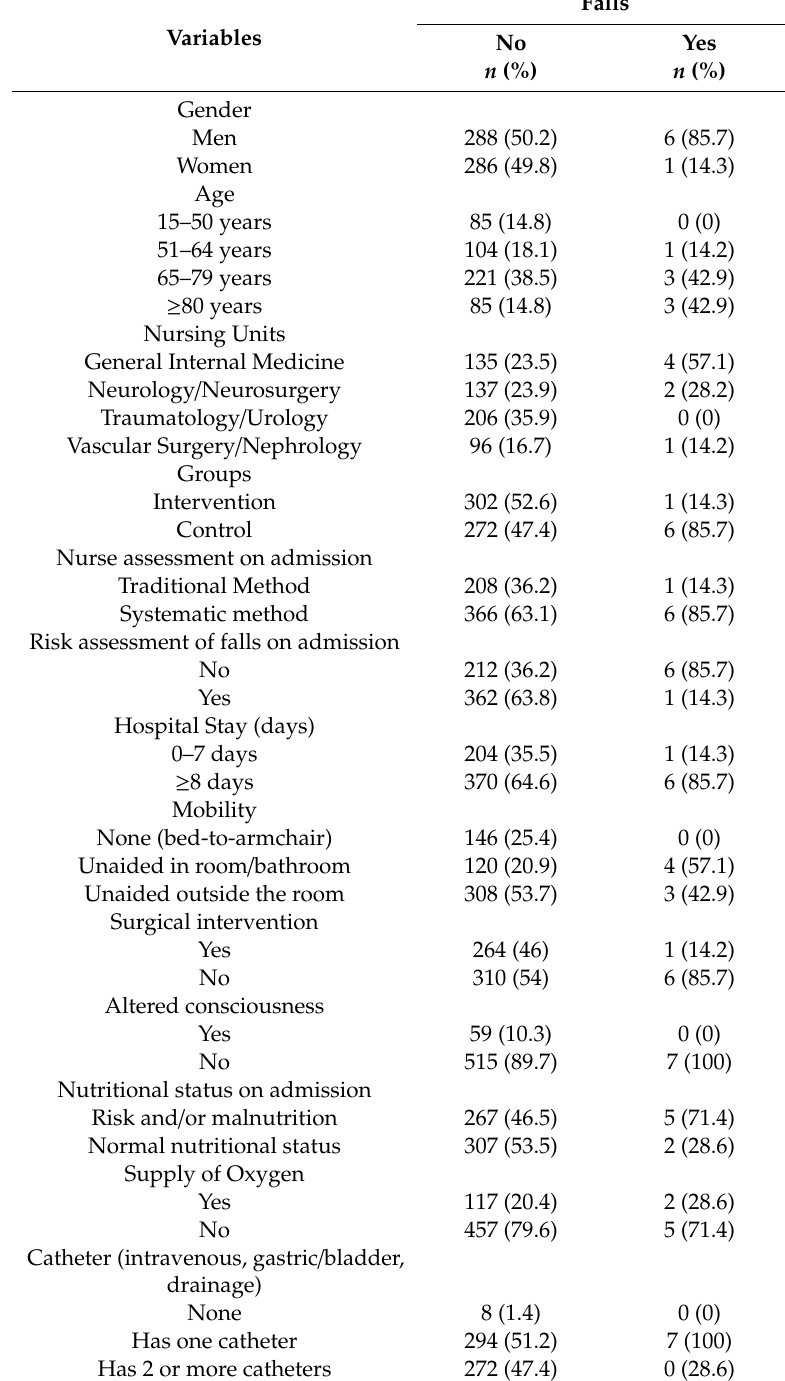
Table 2. Incidence of